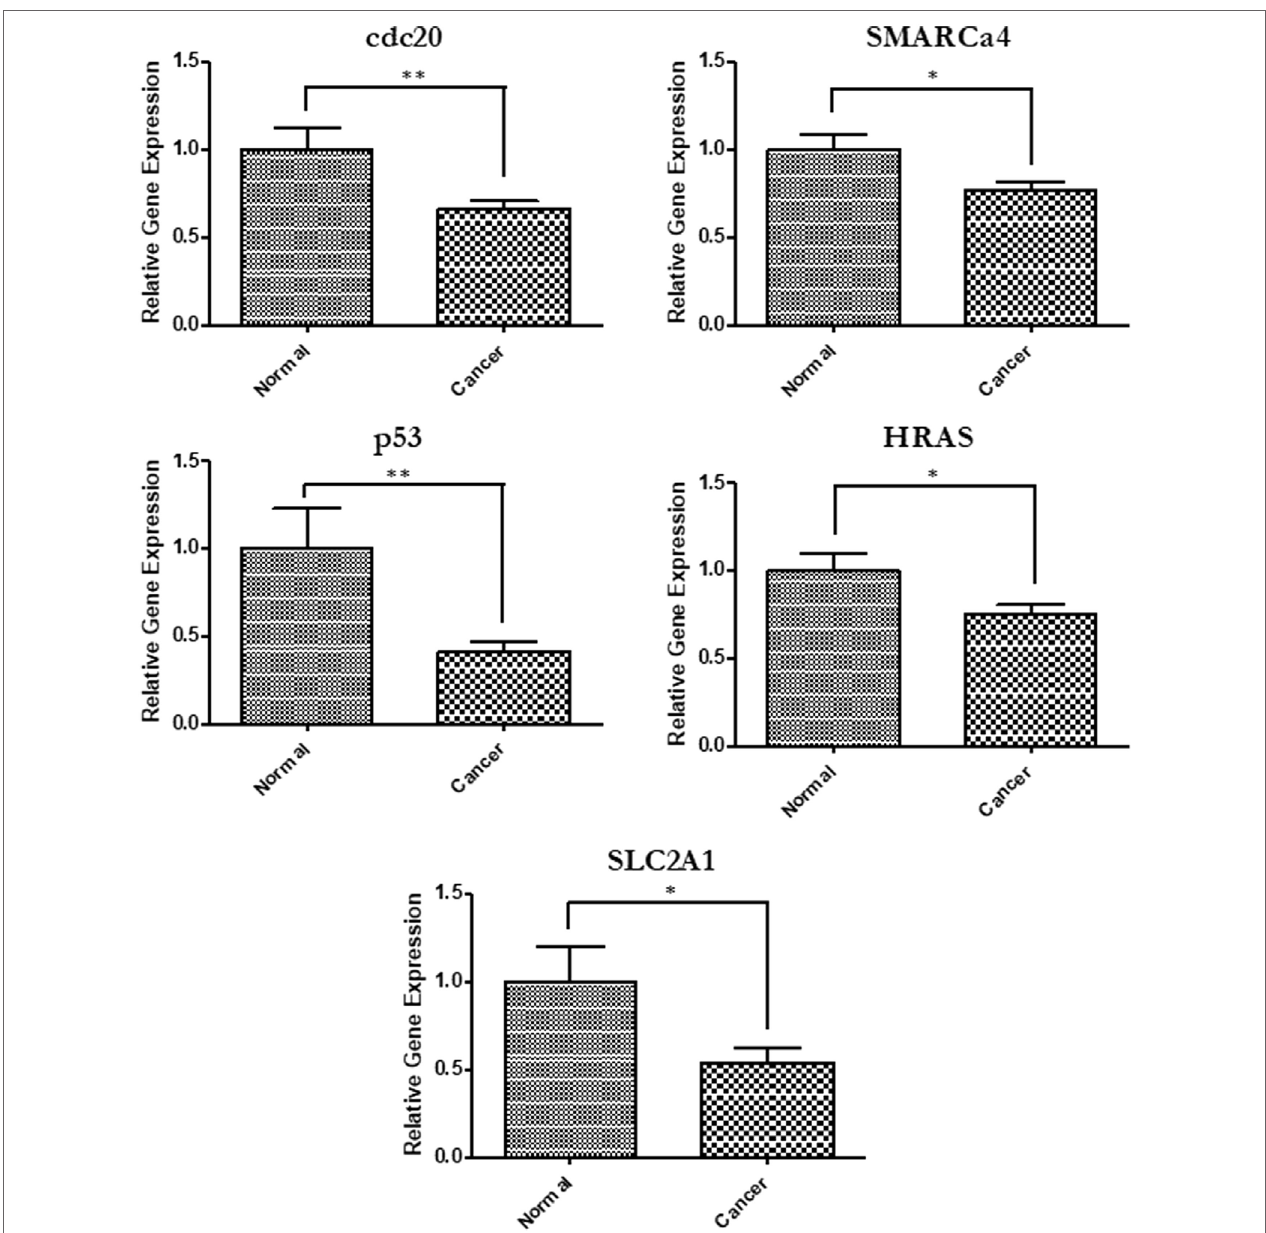
FigUre 2 | Gene expression changes in cells exposed to head and neck squamous cell carcinomas patient serum. Quantitative PCR was used to determine relative gene expression of several cancer-related genes. Primers used for each analysis are listed in Table 2 . SLC2a1 ( p = 0.0198), p53 ( p = 0.0011), cdc20 ( p = 0.0043), HRAS ( p = 0.0306), and Smarca4 ( p =